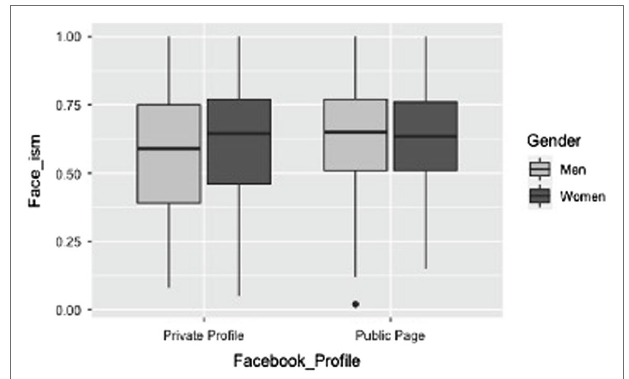
FIGURE 2 | Two-way interaction between gender and type of Facebook profile on face-ism index emerged in Study